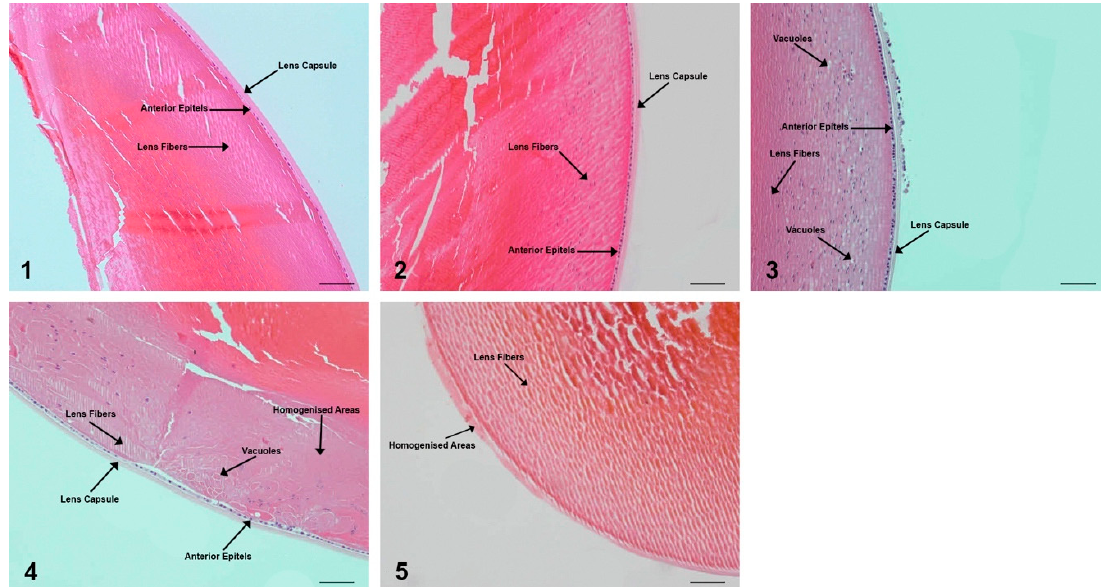
Figure 3. Microphotographs of lens sections stained with hematoxylin and eosin (HEX100). Panels ( 1 ) and ( 2 ) indicate the normal lenticular histology of the GR1 and GR2 rats. Panel ( 3 ) indicates the slight vacuole formation of the GR4 rats. Panel ( 4 ) demonstrates the progressively increasing appearance of vacuoles and homogenized areas in the GR5 rats. Panel ( 5 ) shows the loss of the lens capsule and anterior epithelium in the GR3 rats. The scale bar represents 50 μ m.